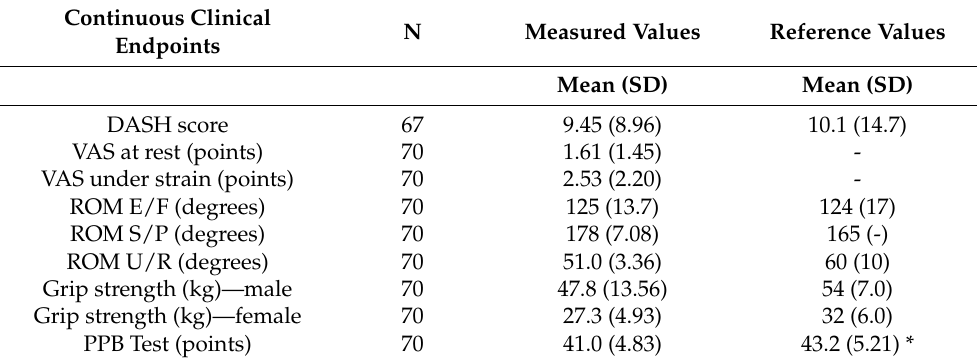
Table 2. Measured continuous clinical endpoints.